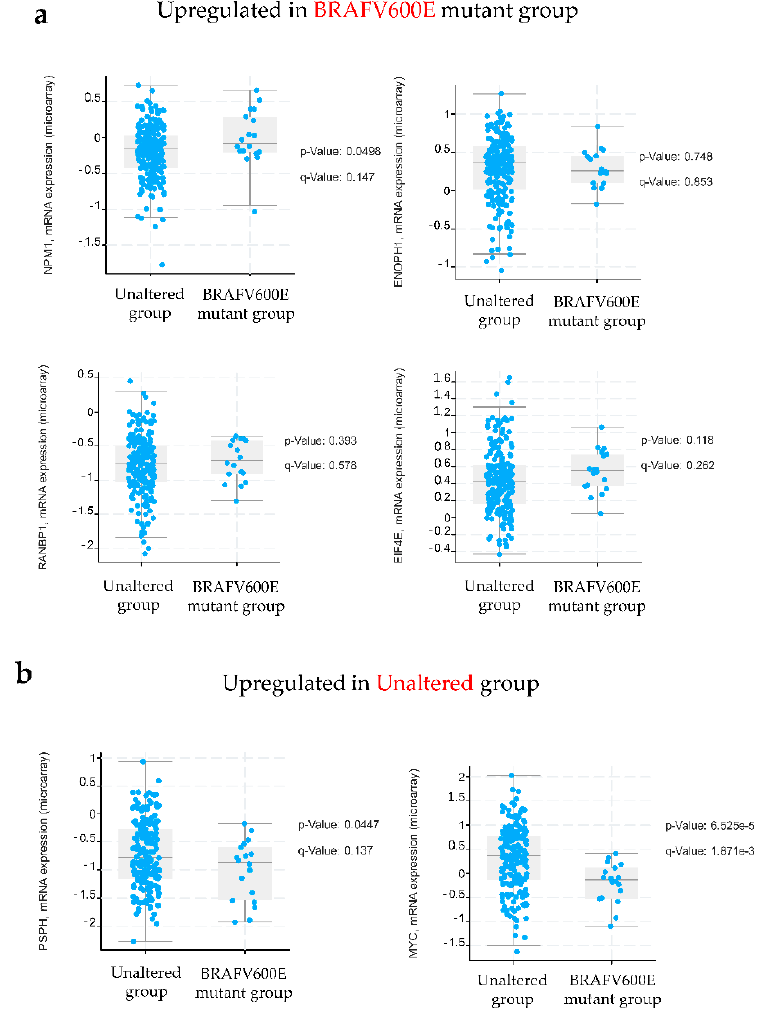
Figure 4. Validation of selected protein candidates in the Cancer Genome Atlas (TCGA) database. Shown here are mRNA expression levels corresponding to selected proteins using the colorectal adenocarcinoma dataset from the TCGA database in cBioPortal that included 20 cases with the BRAFV600E mutation and 200 cases without an indicated mutation (unaltered group). A p -value < 0.05 was considered statistically significant.